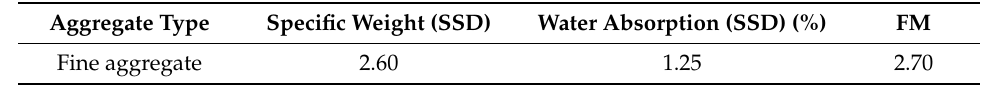
Table 3. Physical and mechanical of lightweight aggregates. Table 2. Physical properties of fine aggregate.